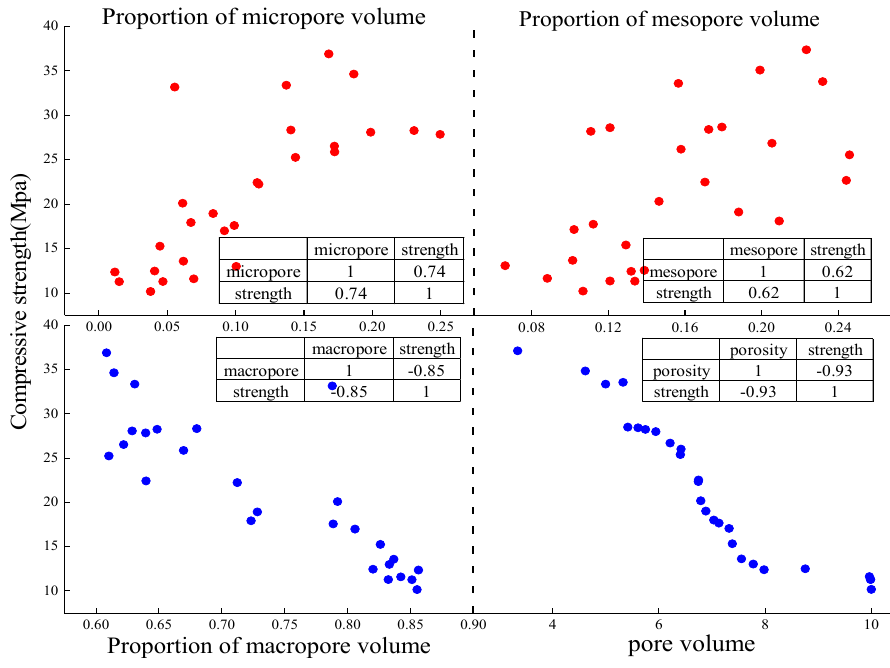
Figure 4. Relationship between the proportion of porosity and compressive strength.